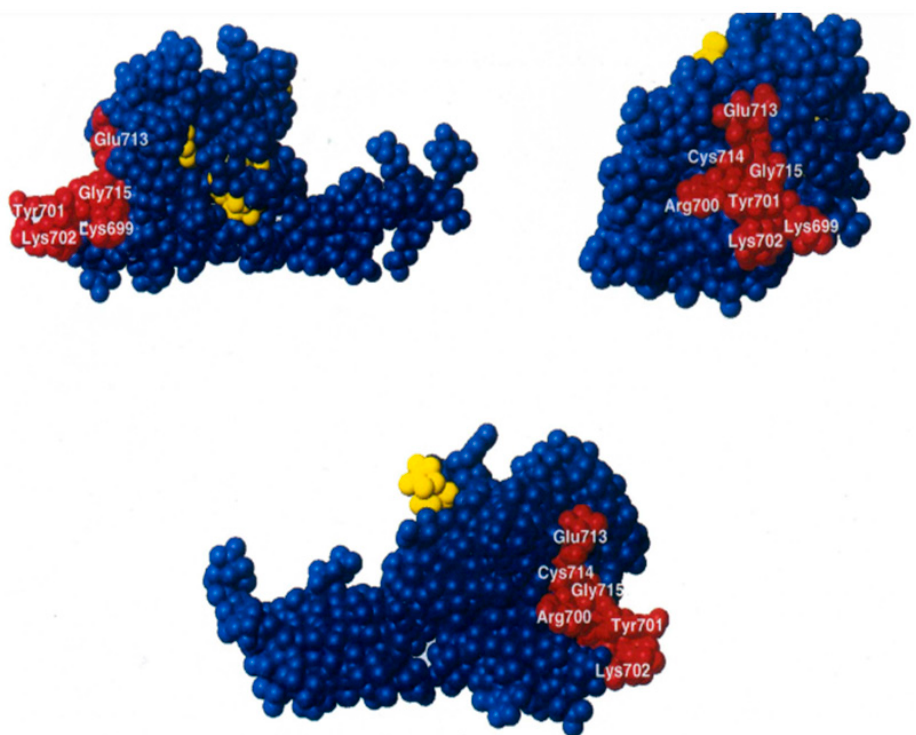
Figure 9. Location of the amino acid residues essential (red) and non-essential (yellow) for the IF2-fMet-tRNA interaction identified by mutagenesis shown within different views the 3D structure of G. stearothermophilus IF2 C2 (blue) determined by NMR spectroscopy [46]. Arg700 corresponds to E. coli Arg847. Figure taken from [43] .